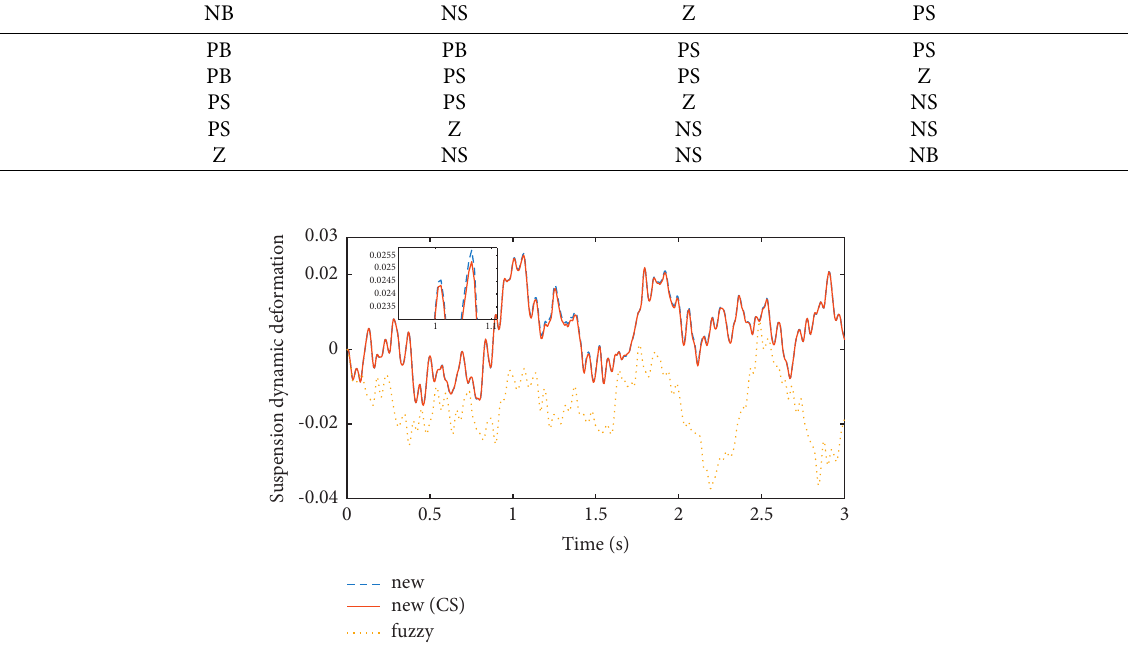
Figure 8: Suspension dynamic deflection 2.